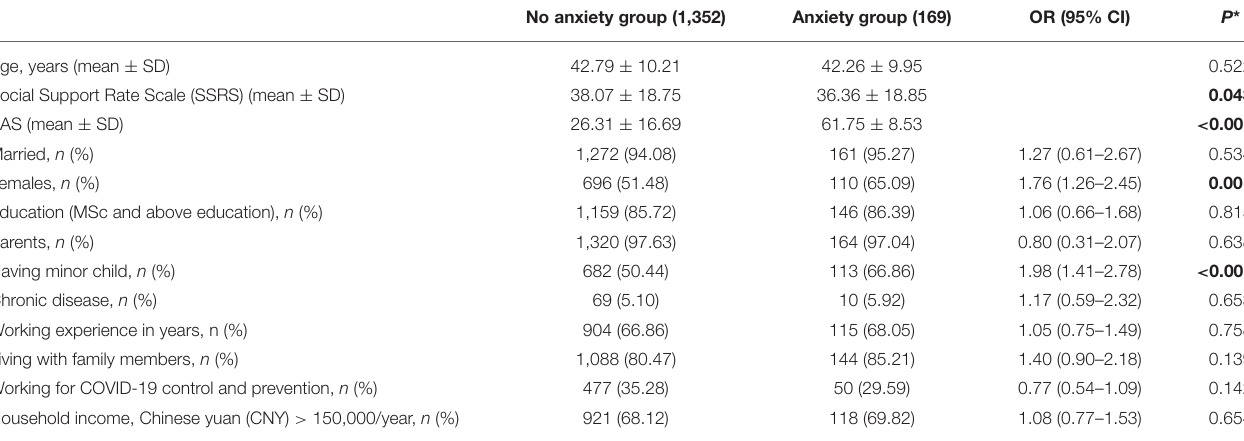
TABLE 1 | Comparison of baseline characteristics between doctors with no anxiety and anxiety symptoms groups.